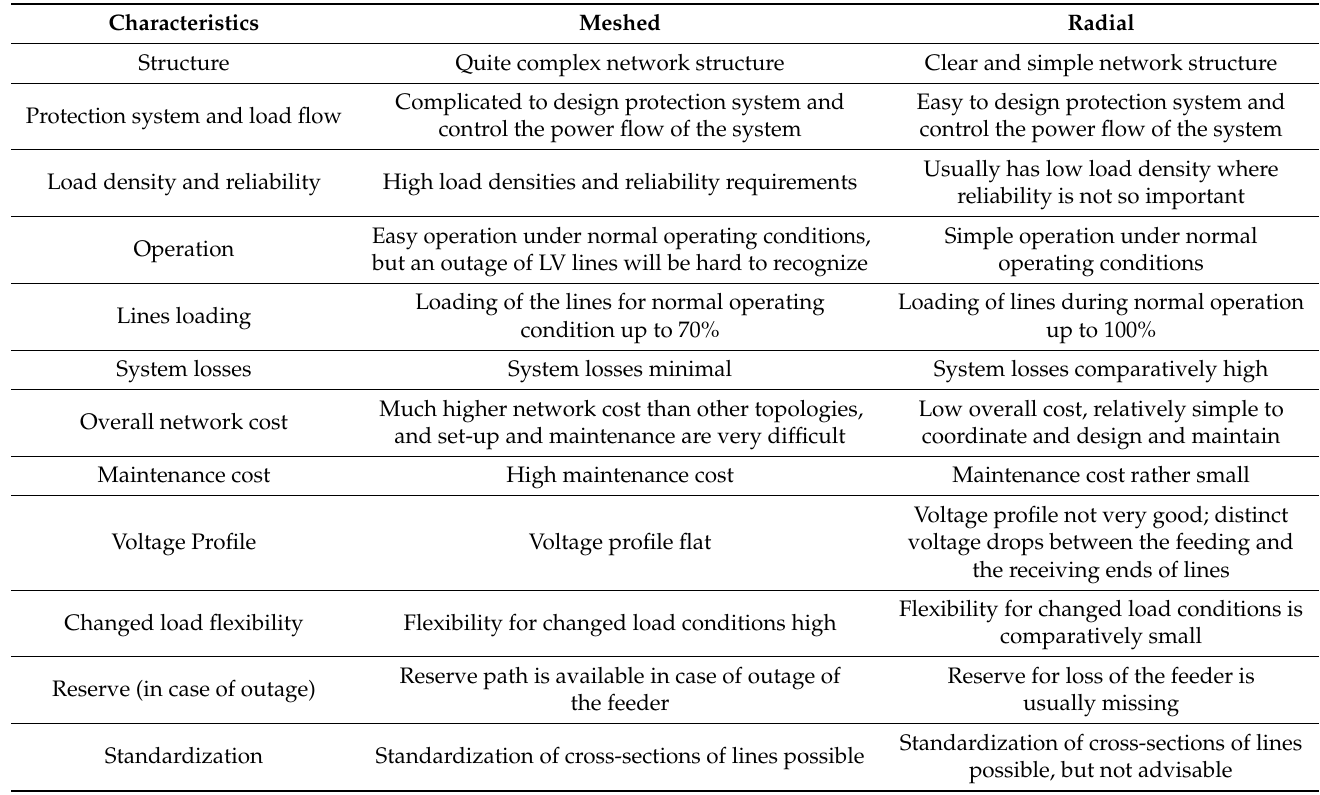
Table 1. Characteristics of radial and meshed distribution